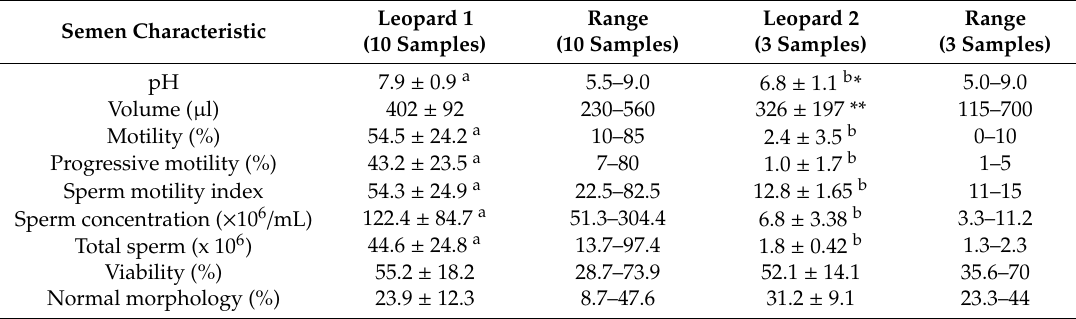
Table 3. Semen characteristics (mean ± SD) of two Sunda clouded leopards living singly.